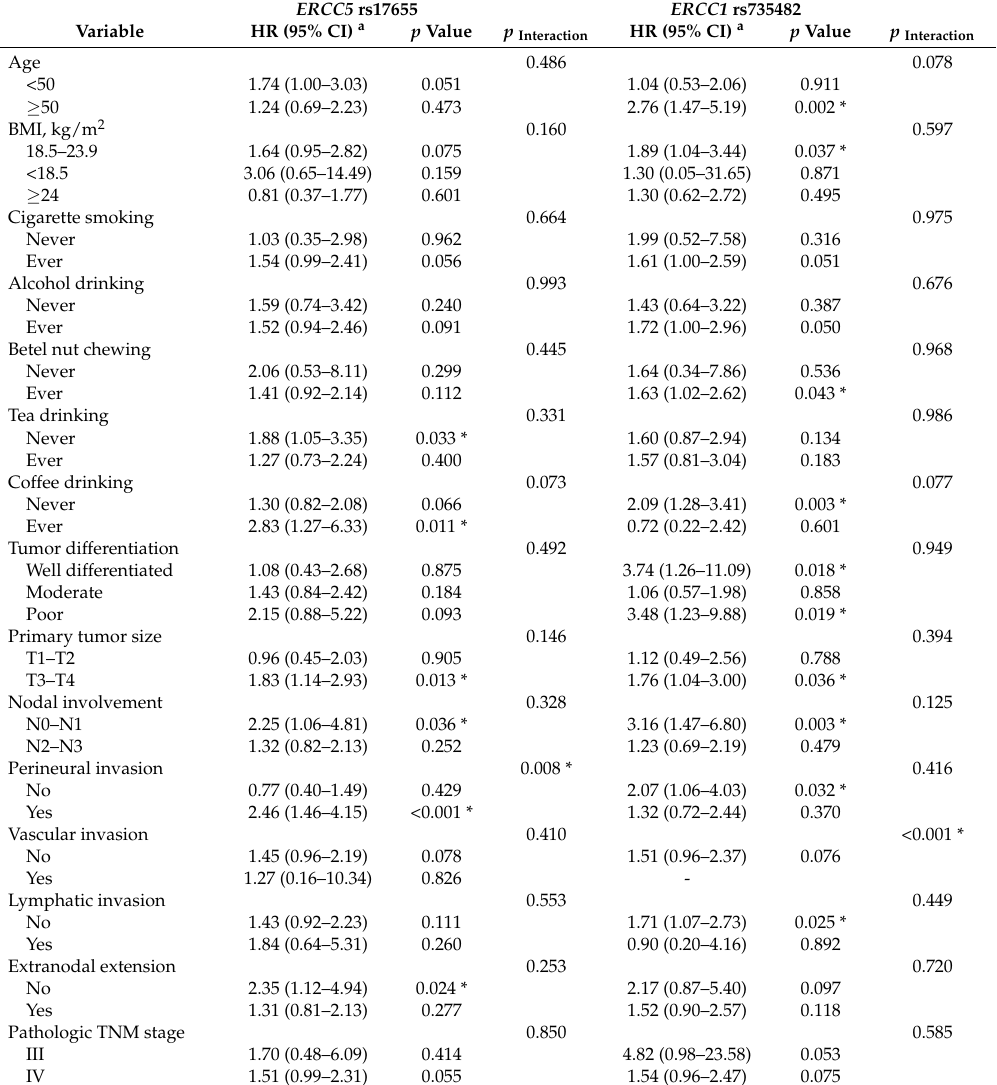
Table 5. Association between the ERCC5 rs17655 and ERCC1 rs735482 polymorphisms and the disease-free survival in OSCC patients treated with CCRT stratified by demographic and clinopathological